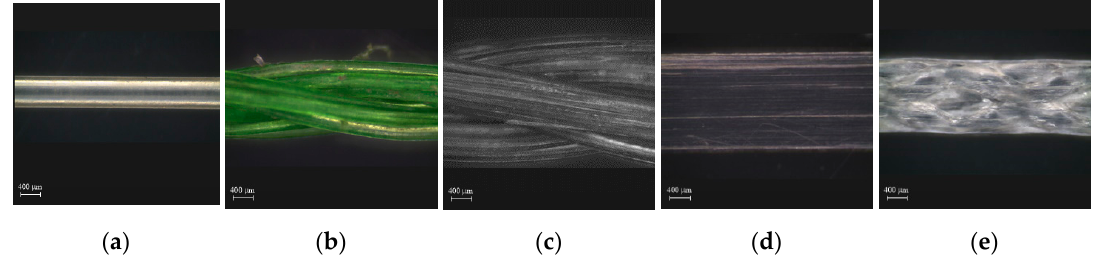
Figure 9. Surfaces of the macro-fibers before the pullout testing: ( a ) WFN1; ( b ) WFN2; ( c ) WFN3; ( d ) CP1; ( e ) CP2 [22].